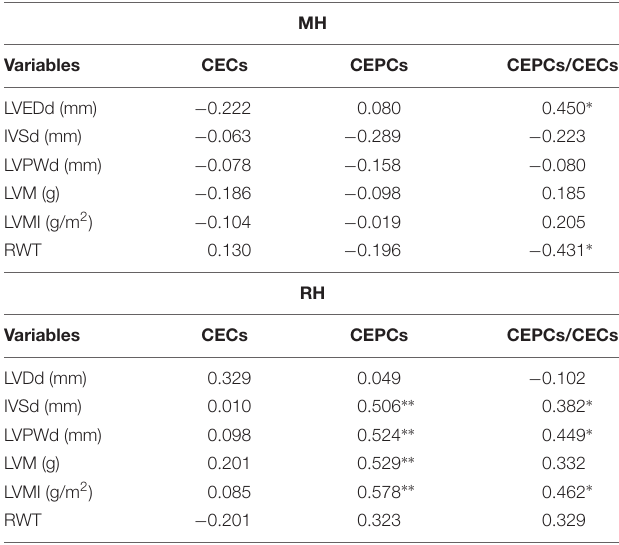
TABLE 4 | CEPCs, CECs and their ratio in hypertensive men with and without LVH.